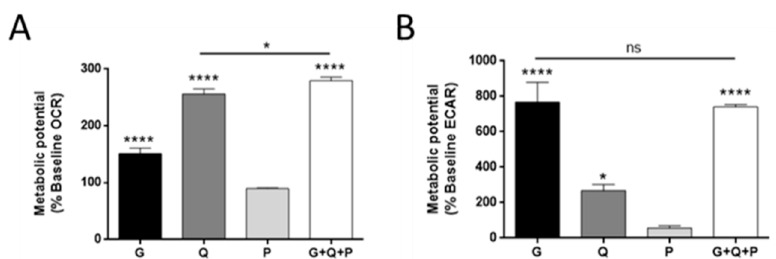
Figure 2. Energetic metabolism in MDA-MB-231 cells. ( A ) Oxygen consumption rate (OCR) and ( B ) extracellular acidification rate (ECAR). Three initial measurements were made in MDA-MB-231 cells incubated in media without glucose, glutamine, and palmitate. These measurements were considered the baseline. Then, 5 mM glucose, 0.5 mM glutamine, and / or 0.5 mM palmitate were injected and additional measurements were taken. Data are expressed as means ± SD of three independent experiments with triplicate samples each. * p < 0.05, **** p < 0.0001 versus control without any metabolic substrate. G—glucose; Q—glutamine; P—palmitate.